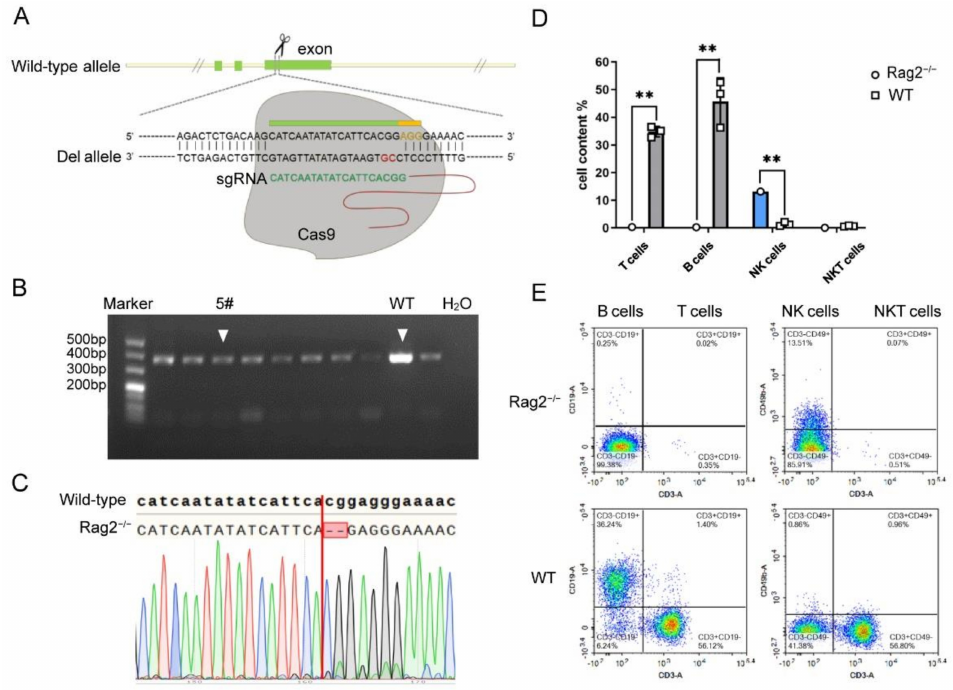
Figure 1. Establishment of Rag2 knockout mice by CRISPR/Cas9 technology. ( A ) Schematic illustra- tion of the strategy for the generation of Rag2 knockout mice. ( B ) PCR genotyping to screen founder mouse, the expected PCR amplicon length was 362 bp. ( C ) PCR amplicons of candidate founder mice were sequenced, and two bases (CG) were deleted. ( D ) Flow cytometry test analysis of T, B, and NK cells in the peripheral blood of wild-type C57BL/6 mice and homozygous Rag2 − / − mice. The corresponding cytometric dot-plots are shown in figure ( E ). The statistical significance was evaluated using the unpaired t -tests, ** p <